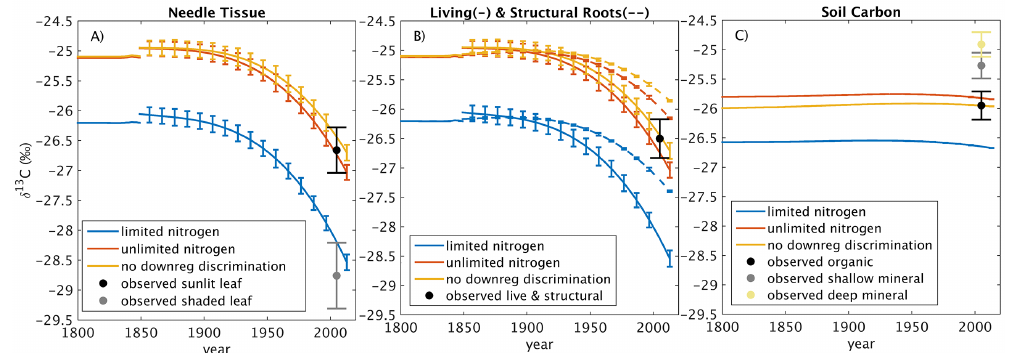
Figure 5. Simulation of δ 13 C of (a) bulk needle tissue, (b) bulk roots, and (c) bulk soil carbon. A description of model formulations are provided in Table 2. Uncertainty bars for simulations represent 95% confidence intervals of δ 13 C variation as a result of cycling the site-level meteorology observations. The observed values are from Schaeffer et al. (2008) with uncertainty bars representing standard error. Solid lines and dashed lines in middle panel represent living roots and structural roots, respectively.